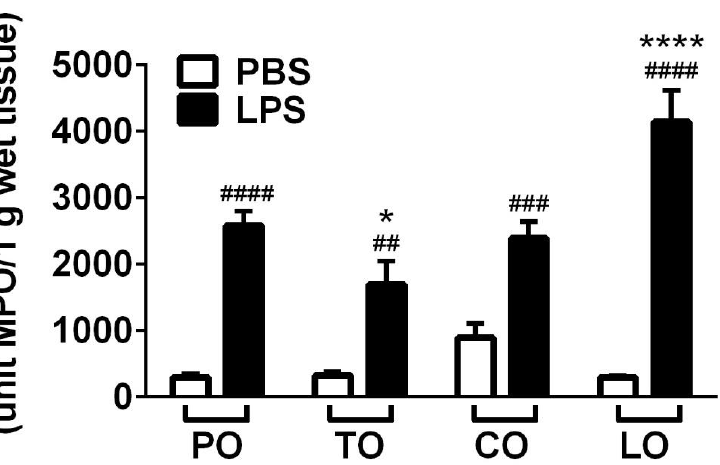
Figure 4. Results of myeloperoxidase (MPO) activity measurements. ( n = 8–10 / group, ## p < 0.005, ### p < 0.0005, #### p < 0.0001 vs. respective PBS-treated group, * p < 0.05, **** p < 0.0001 vs.